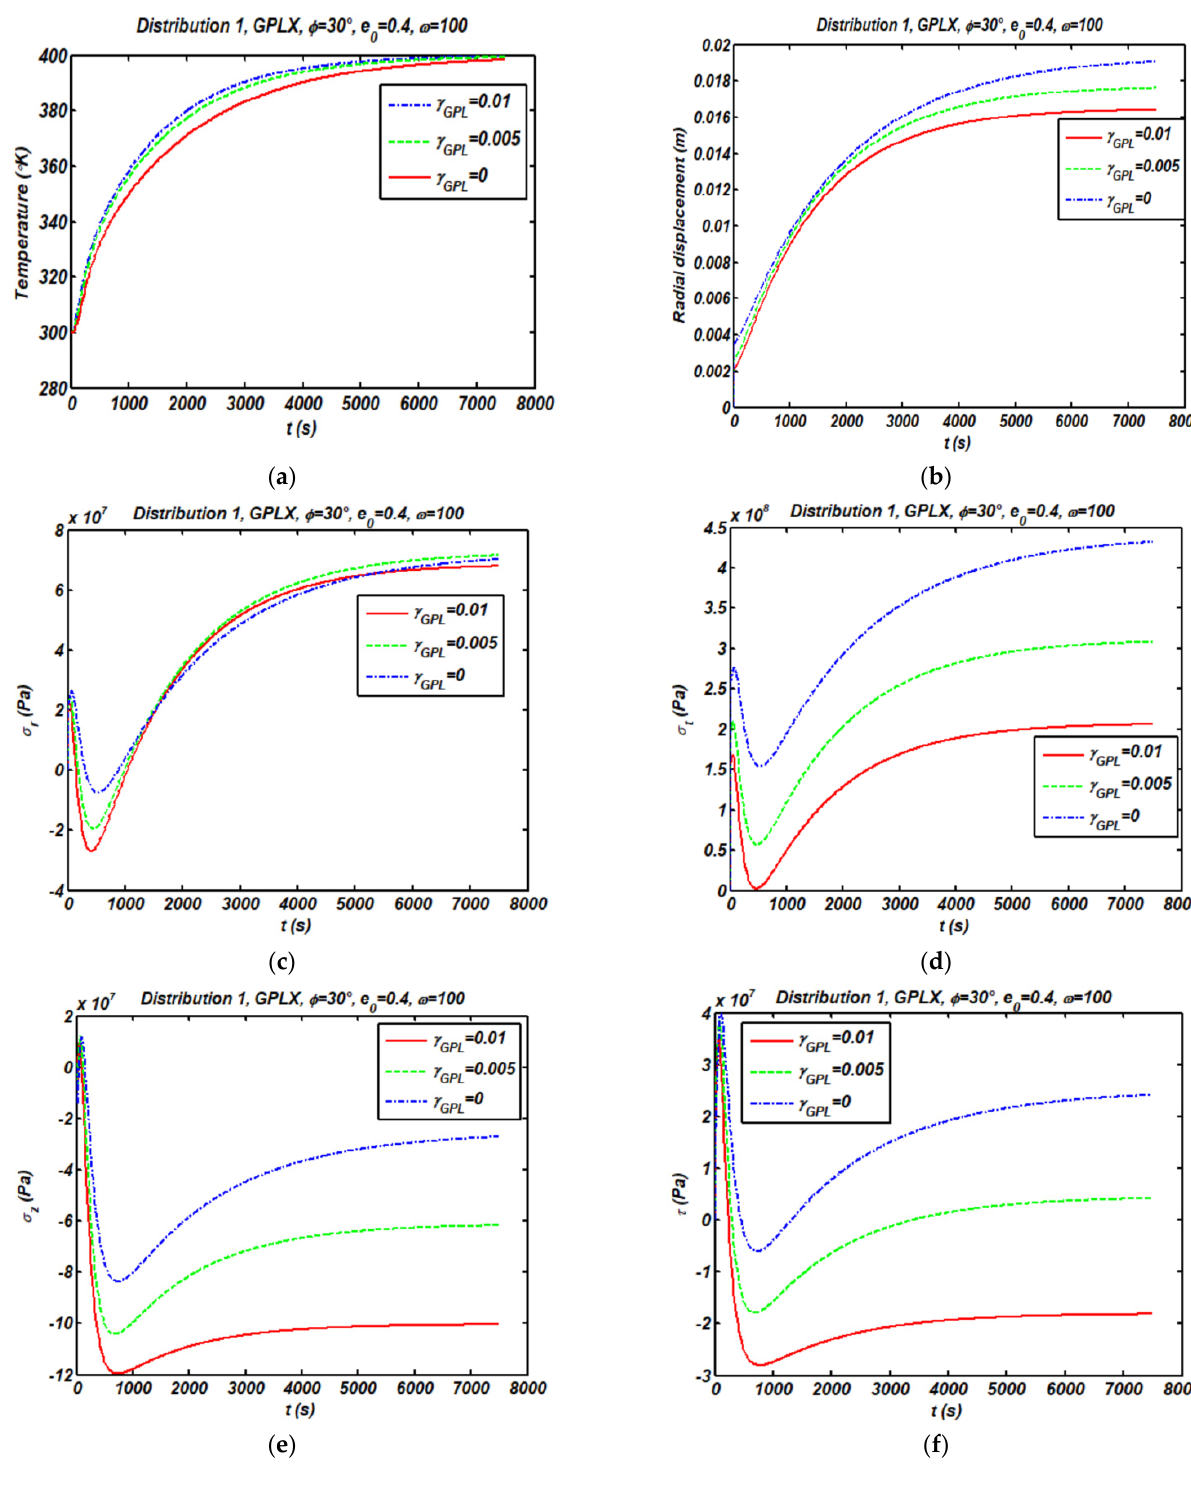
γ Figure 7. Influence of GPL on the transient temperature ( a ), radial displacement ( b ), and stress Figure 7. Influence of γ GPL on the transient temperature ( a ), radial displacement ( b ), and stress state ( c – f ) for a center point of truncated cone (D1-GPL X; e 0 = 0.4; φ = 30 ◦ ; ω = 100 state ( c – f ) for a center point of truncated cone (D1-GPL X; 0 e = 0.4;